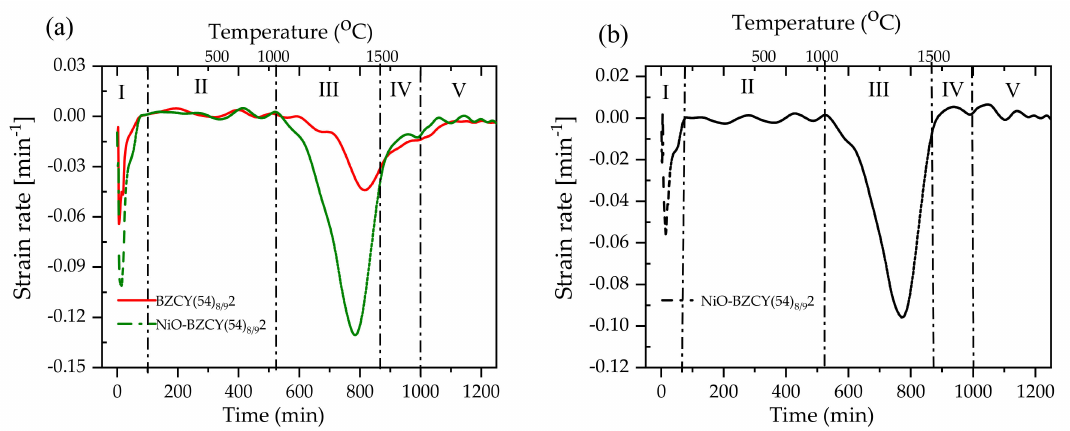
Figure 5. ( a ) Strain rates of the tape-casted BZCY(54) 8 / 9 2 and NiO-BZCY(54) 8 / 9 2 support substrates ( b ) Mismatch of strain rates (the di ff erence between individual strain rates BZCY(54) 8 / 9 2 and NiO-BZCY(54) 8 / 9 2) between BZCY(54) 8 / 9 2 and NiO-BZCY(54) 8 / 9 2 support substrates determined as the net di ff erence between the curves in Figure